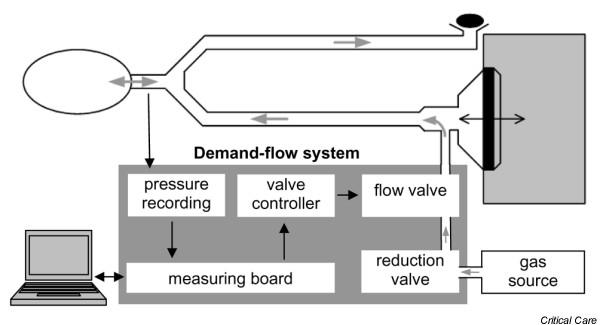
Schematic description of the demand-flow system structure.